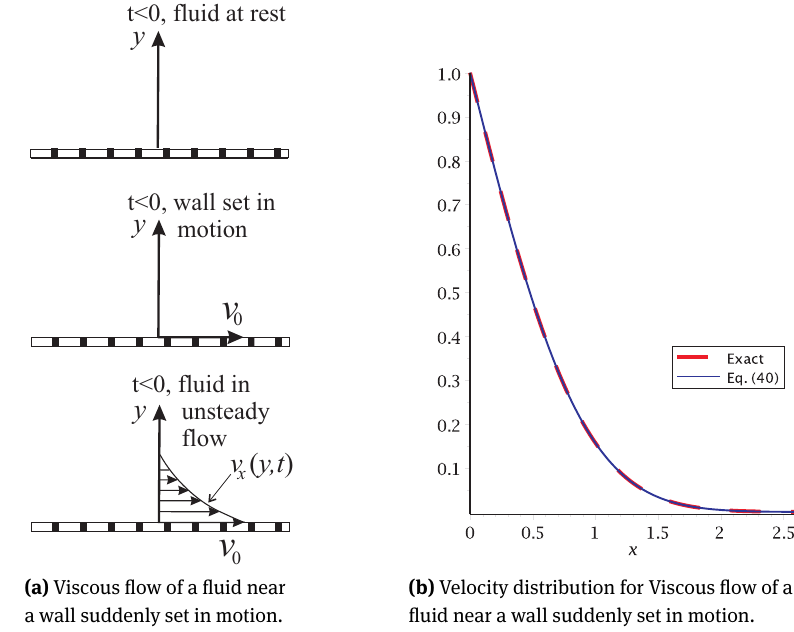
Figure 8: Error function applied on time-dependent flow of Newtonian